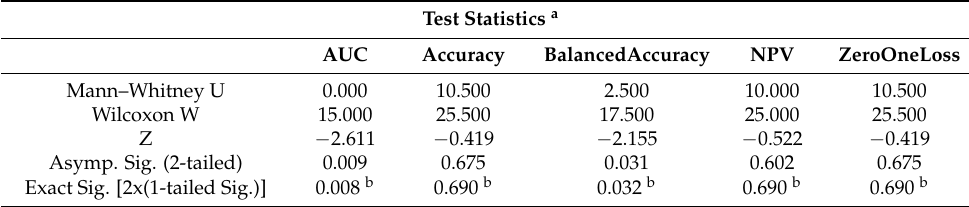
Table 3. Test statistics of Mann–Whitney U test.